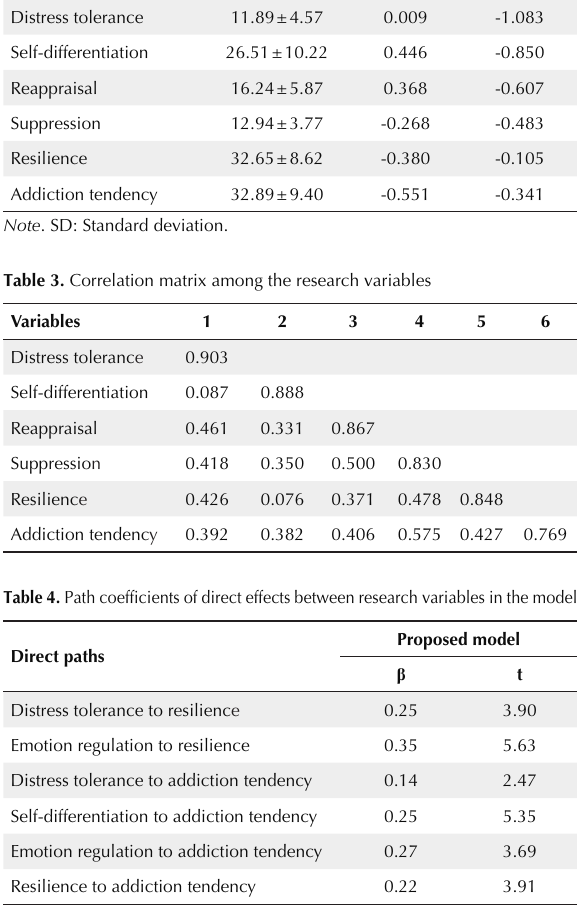
Table 2. Means, SD, skewness, and kurtosis of the research variables (n = 314) Variables